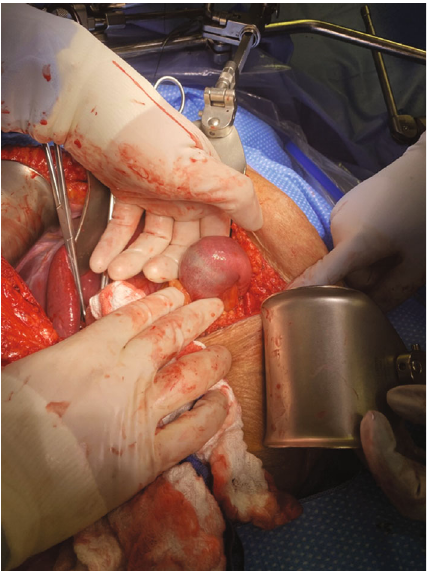
Figure 4: Intraop picture of the impacting gallstone in the proximal jejunum before extraction.